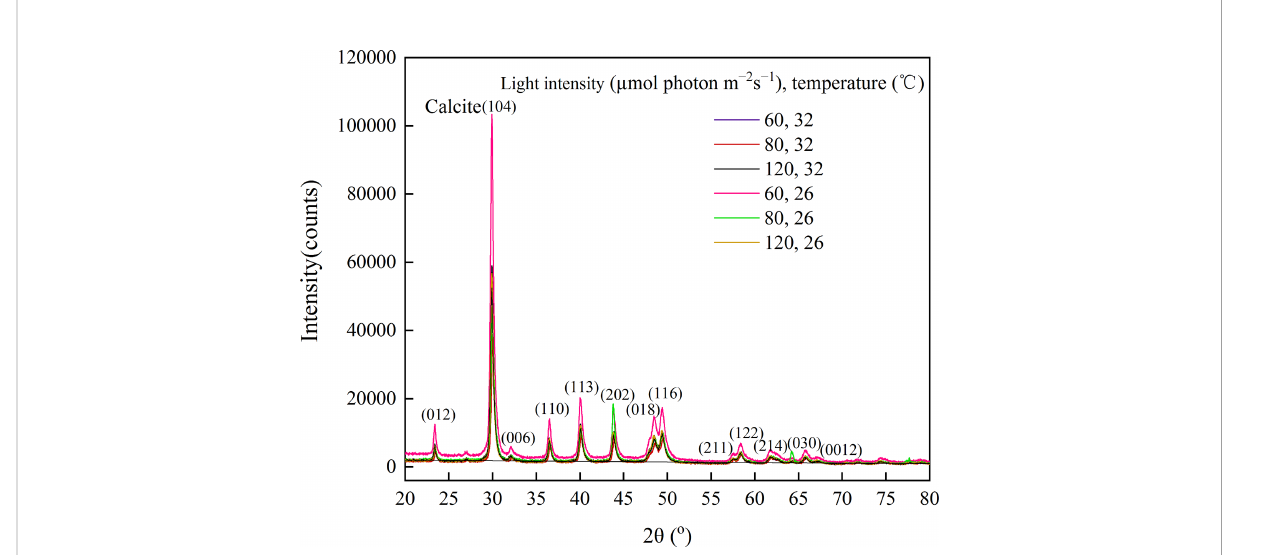
FIGURE 5 Mineral changes in A. cf. fragilissima exposed to different culture conditions using